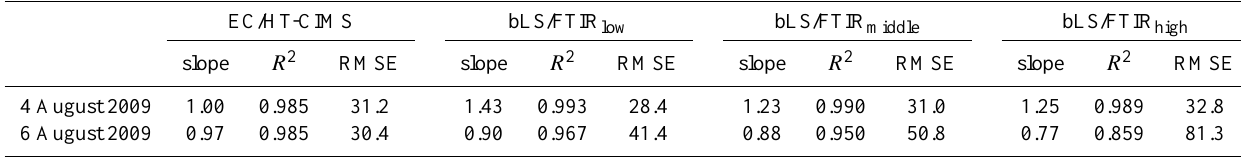
Table 5. Parameters of linear regressions of NH 3 concentrations measured by impingers and corresponding concentrations calculated with bLS, using the emissions F volat derived from the respective methods (Fig. 9); RMSE=root mean squared error (in µgm − 3